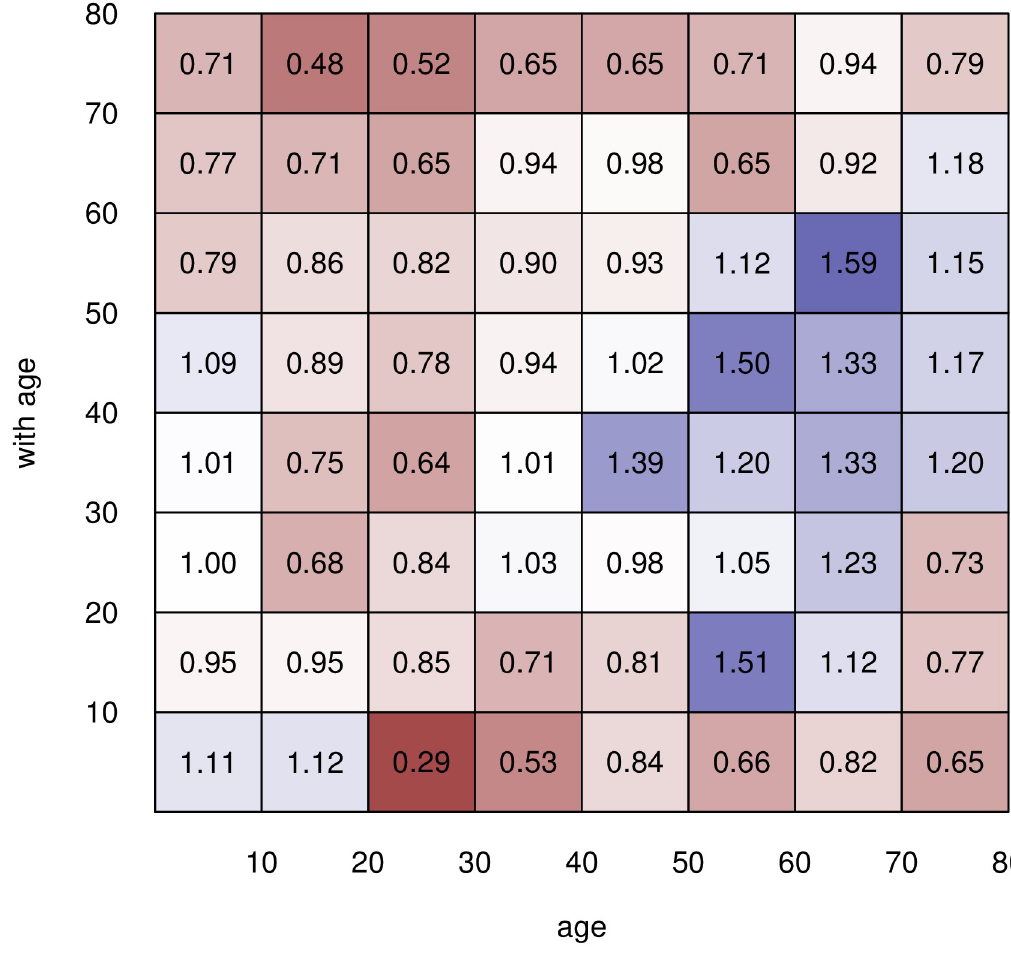
Fig 4. Differences in contact rates by sex. Sex ratios (men/women) of overall contact rates λ age groups in the absence of lockdown measures (based on [15]).